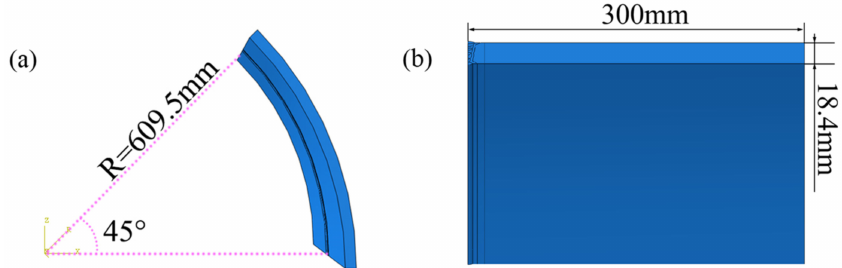
Figure 1. Specification of 1/8 geometric model of pipeline: ( a ) angle and radius, and ( b ) wall thickness and length of geometric model.